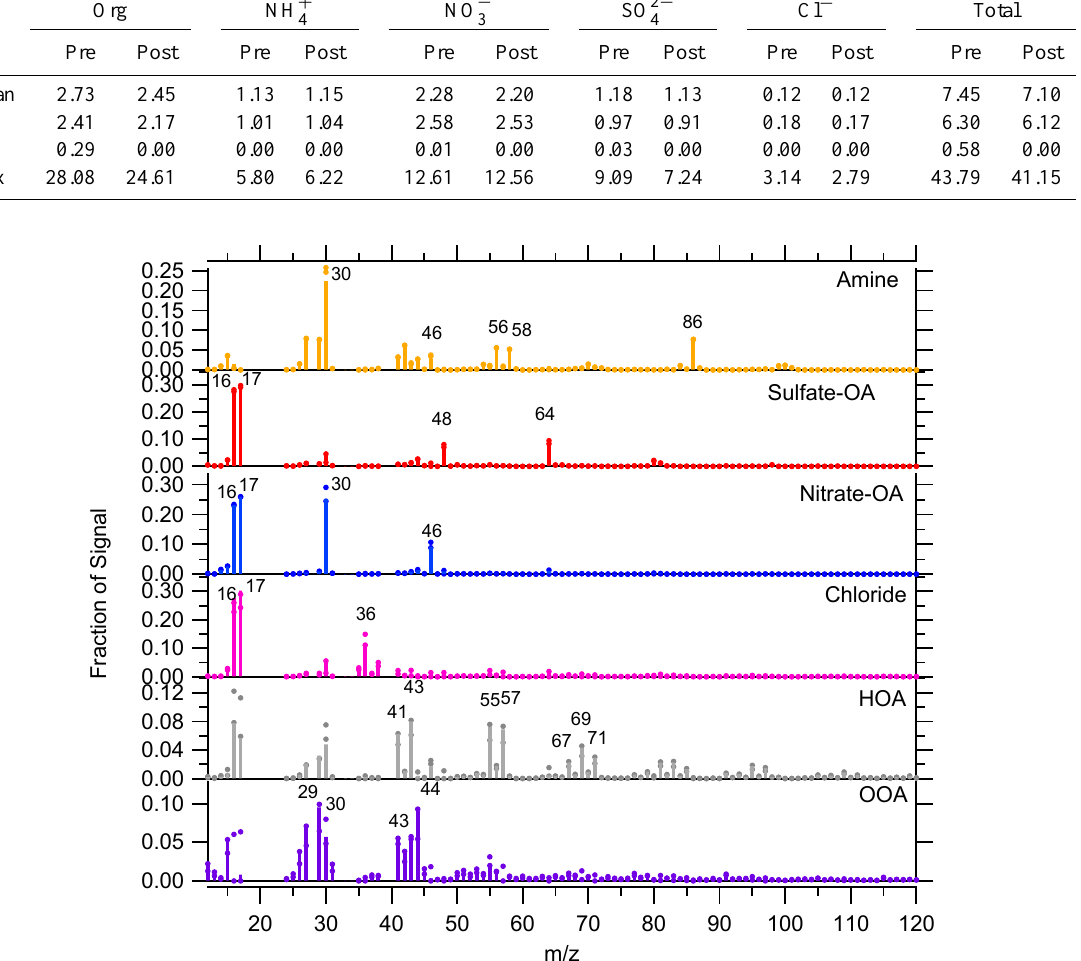
Figure 5. Mass spectra of factors from the six-factor solution from PMF Full MS analysis. Bars represent the central, chosen rotation, and dots show the range in mass spectral variation from FPeak rotations ( − 10 and